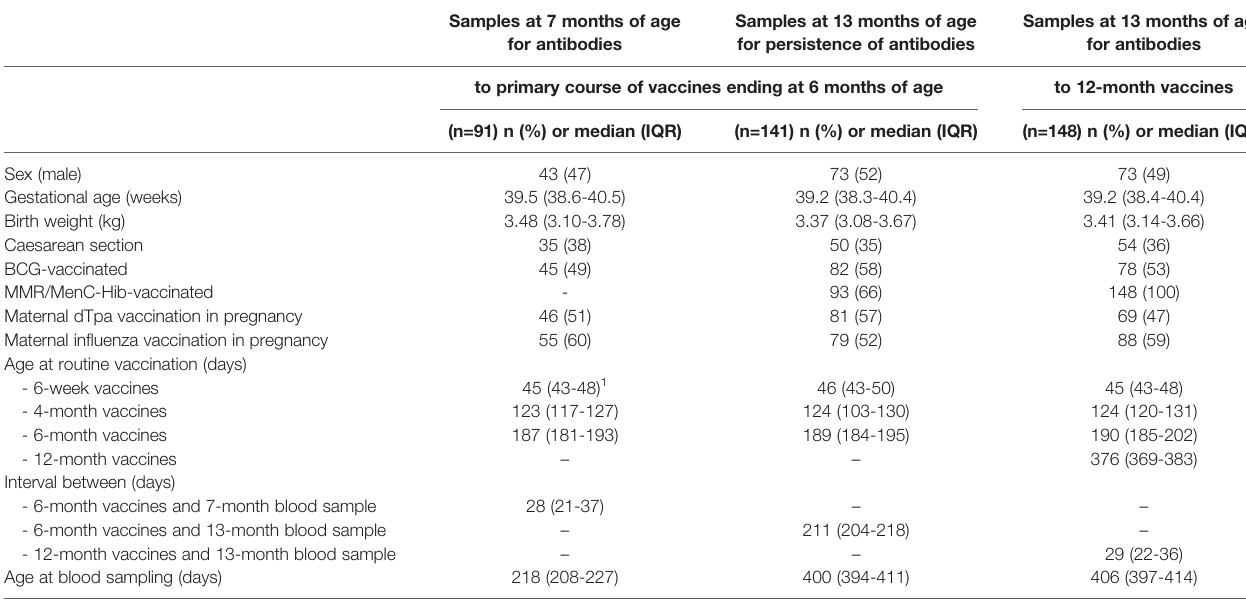
TABLE 1 | Characteristics of study participants.